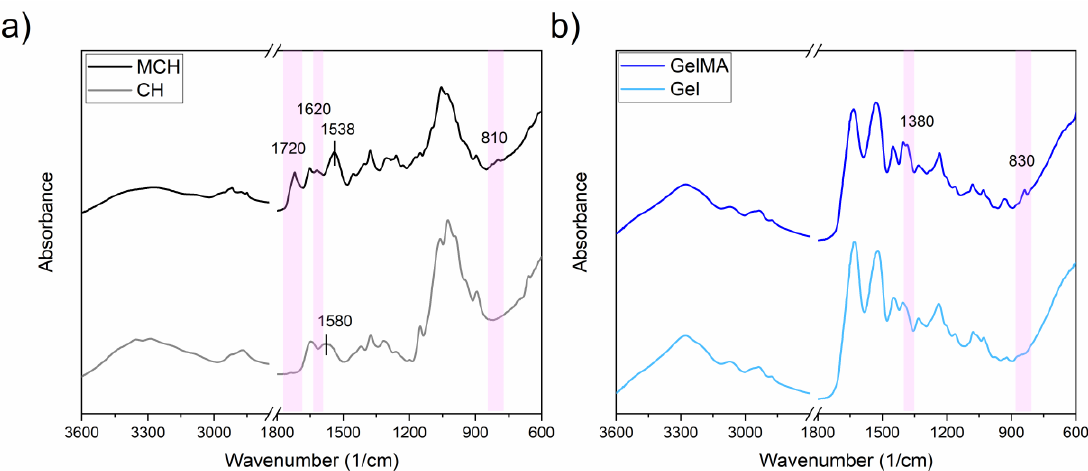
Figure 3. FTIR spectra of ( a ) CH and ( b ) Gel before and after the methacrylation reaction.